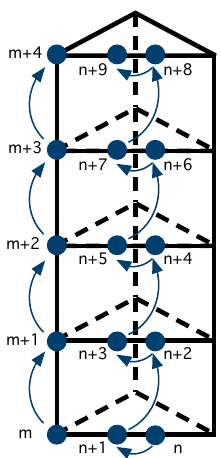
Figure 4. Vertical numbering of degrees of freedom (shown in filled circles) associated with vertices and horizontal edges. Only one set of vertically aligned degrees of freedom of each type is shown. The arrows outline the order in which the degrees of freedom are num-